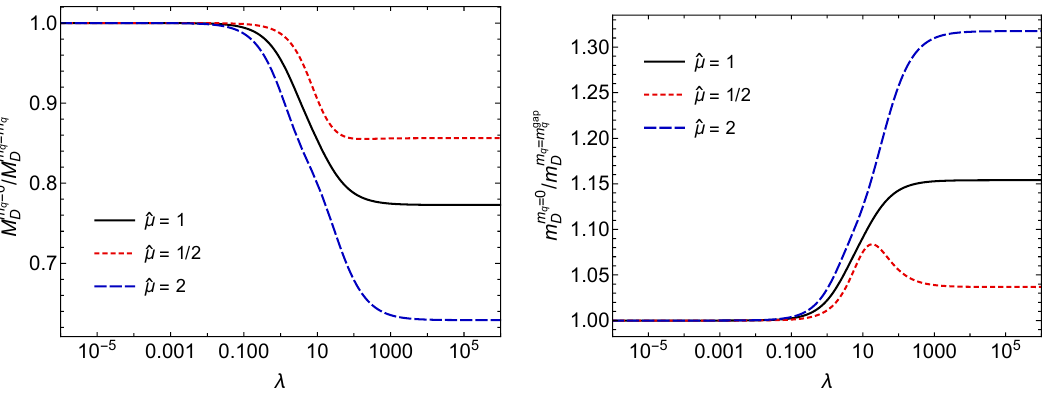
Figure 9 . Ratio of the numerical solutions of the M D and m D gap equations for the two quark mass schemes: m q = 0 and m q = m gap (6.13). q